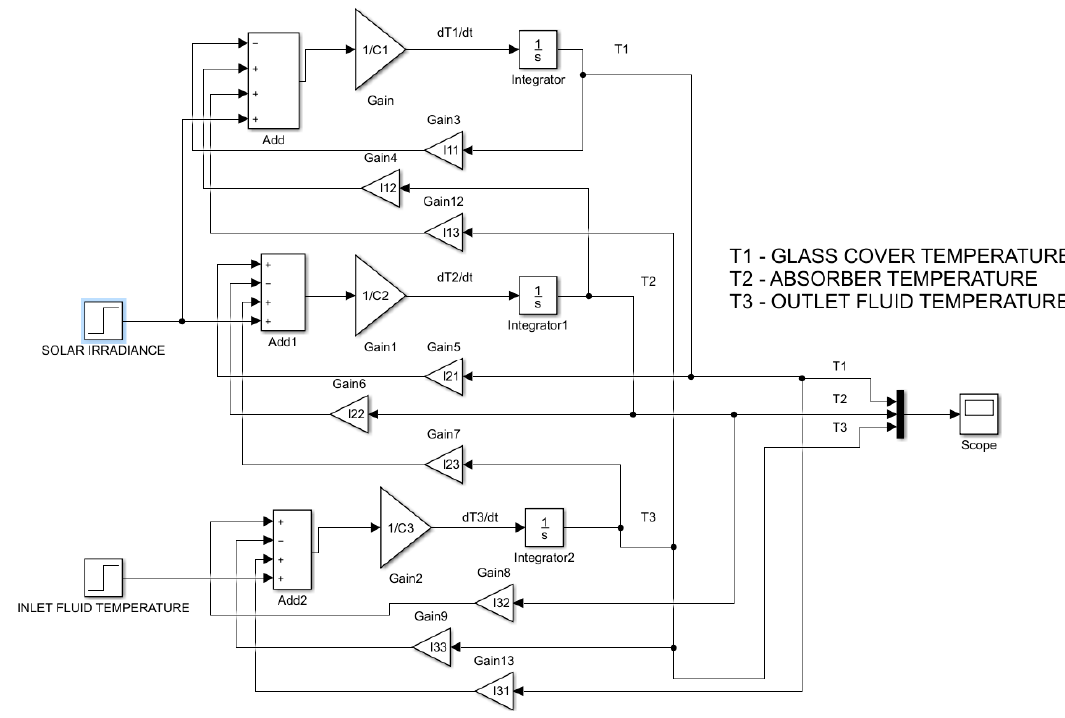
Figure 9. The equivalent thermal network implemented in Simulink.